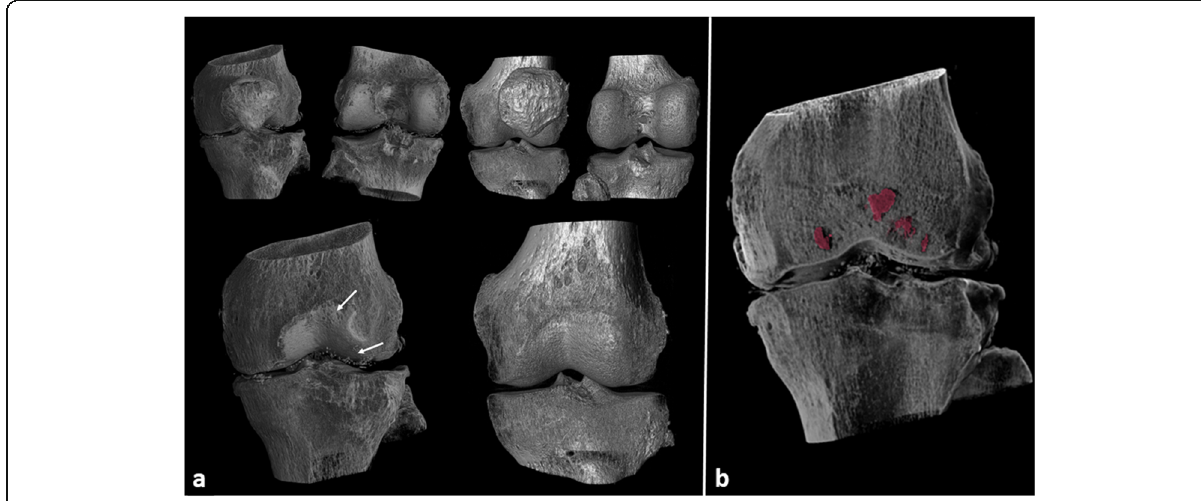
Fig. 5 Three-dimensional displays of the 60 keV monoenergetic for two selected samples. a, left, OA (sample 2); a , right normal (sample 3). White arrows show cartilage defects (top) and calcifications (bottom) on OA. b Illustration of segmented bone cysts (in red) with the semiautomatic region growing tool in OA sample (sample